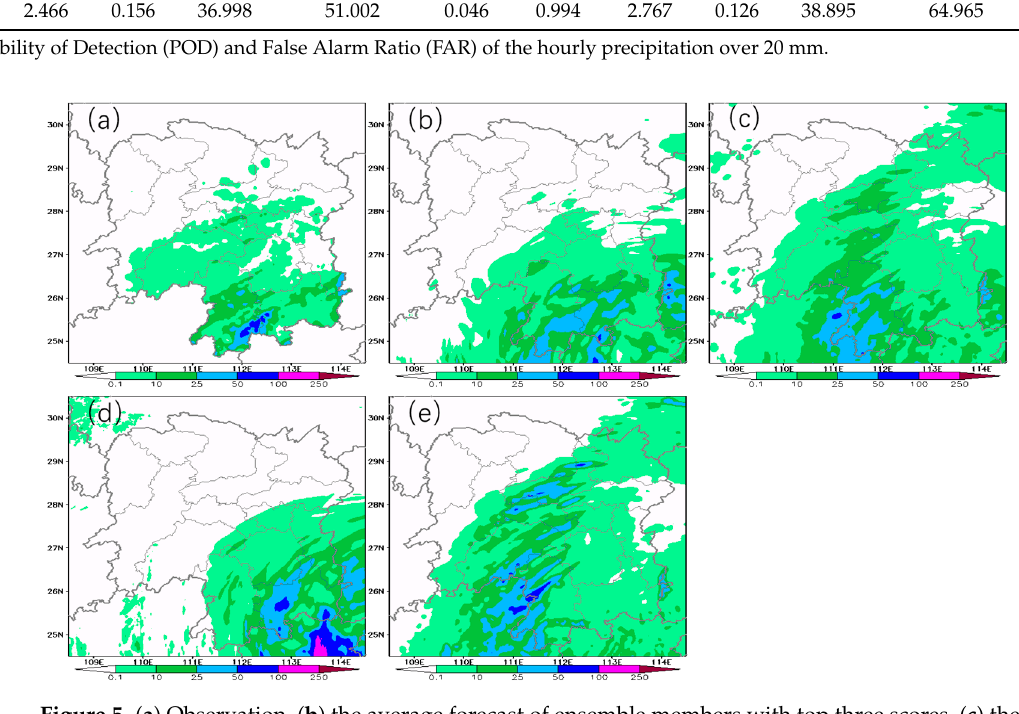
Figure 5. ( a ) Observation, ( b ) the average forecast of ensemble members with top three scores, ( c ) the forecast of the ensemble member with the highest score, ( d ) forecast at the nearest forecast reference time of the GRAPES-CHAF model and ( e ) the SMS-WARR model from 20:00 on the 25 August to 02:00 on the 26 August 2019.